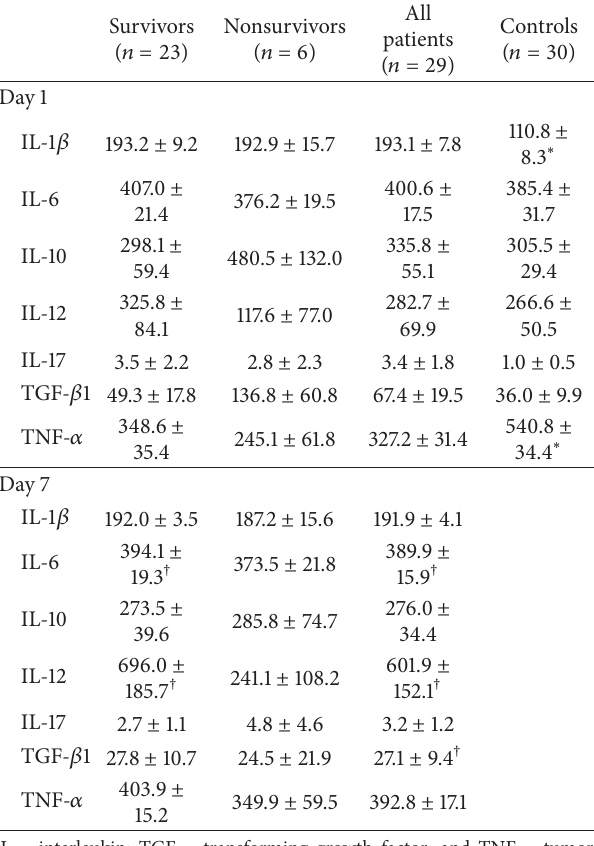
Table 4: Cytokine responses (pg/mL, mean ± standard error mean) on days 1 and 7 in survivors, nonsurvivors, and control